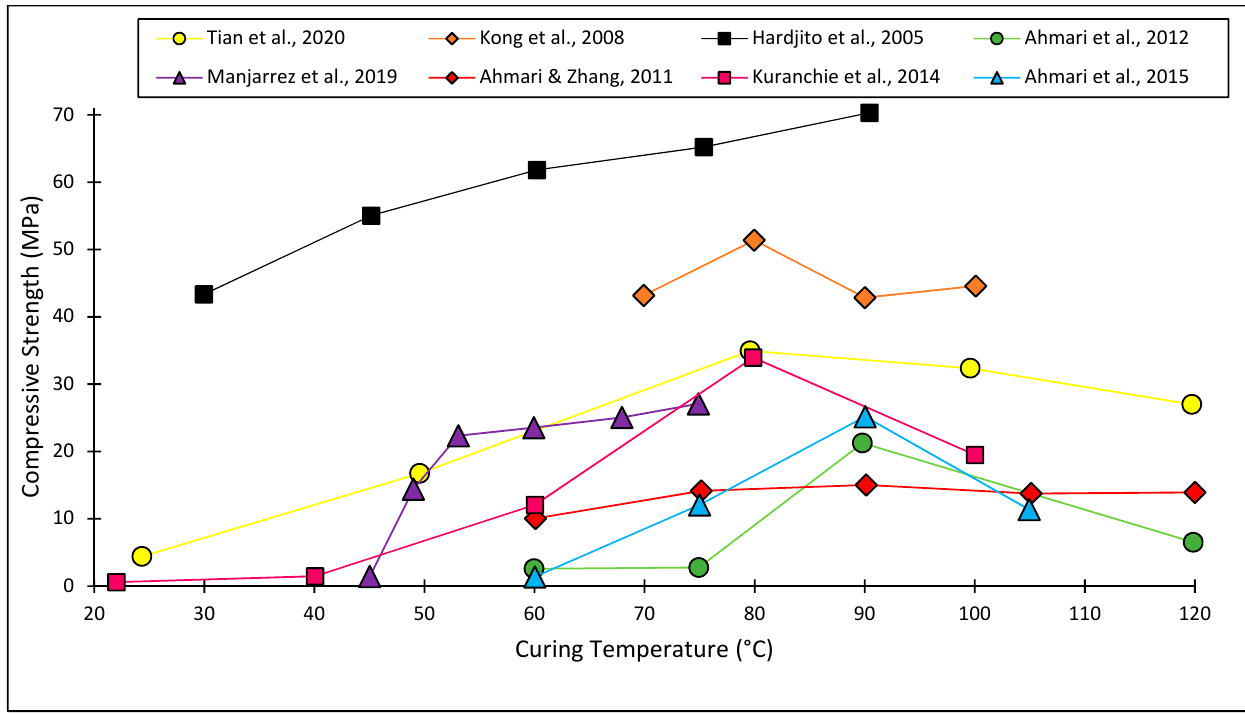
Figure 17. Compressive strength as a function of curing temperature; data obtained from previous investigations [2,3,5,22,25,43–45].